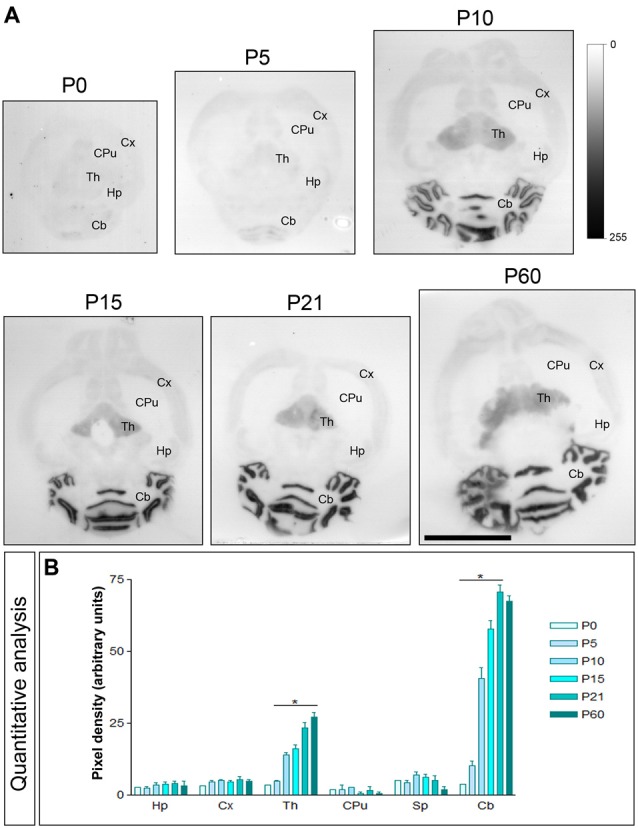
Developmental and regional distribution of the T-type Ca2+ channel Cav3.1 subtype in the mouse brain. (A) Cav3.1 protein distribution was visualized on histoblots of brain horizontal sections at various stages of postnatal development using an affinity-purified anti-Cav3.1 antibody. Cav3.1 was expressed in the brain since the day of birth (P0), and at all stages the strongest expression was detected in the Cb and Th, with the lowest intensity in the CPu. (B) The histoblots were scanned and densitometric measurements from four independent experiments were averaged to compare the protein densities for each developmental time point. This quantitative analysis indicates that Cav3.1 expression increased progressively during postnatal development in the Cb and Th. In contrast, Cav3.1 expression does not change significantly from P0 to P60 in the Hp, Cx, CPu and Sp. Error bars indicate SEM; *P < 0.05 compared with P60. Scale bar, 0.5 cm.